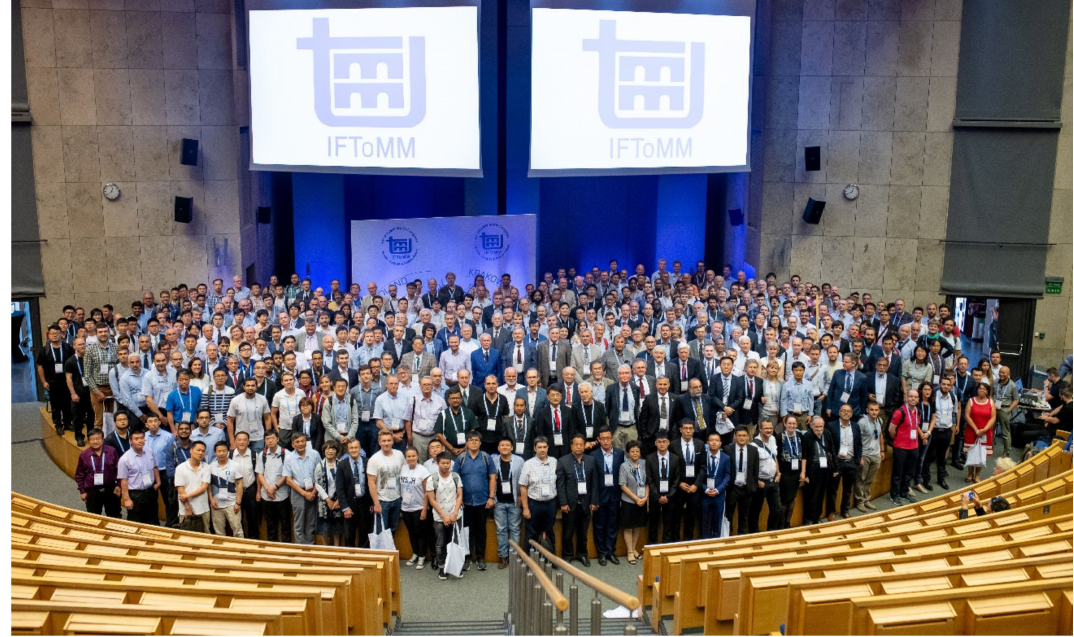
Figure 7. Group photo of the attendees at the celebration of the IFToMM 50-year anniversary.